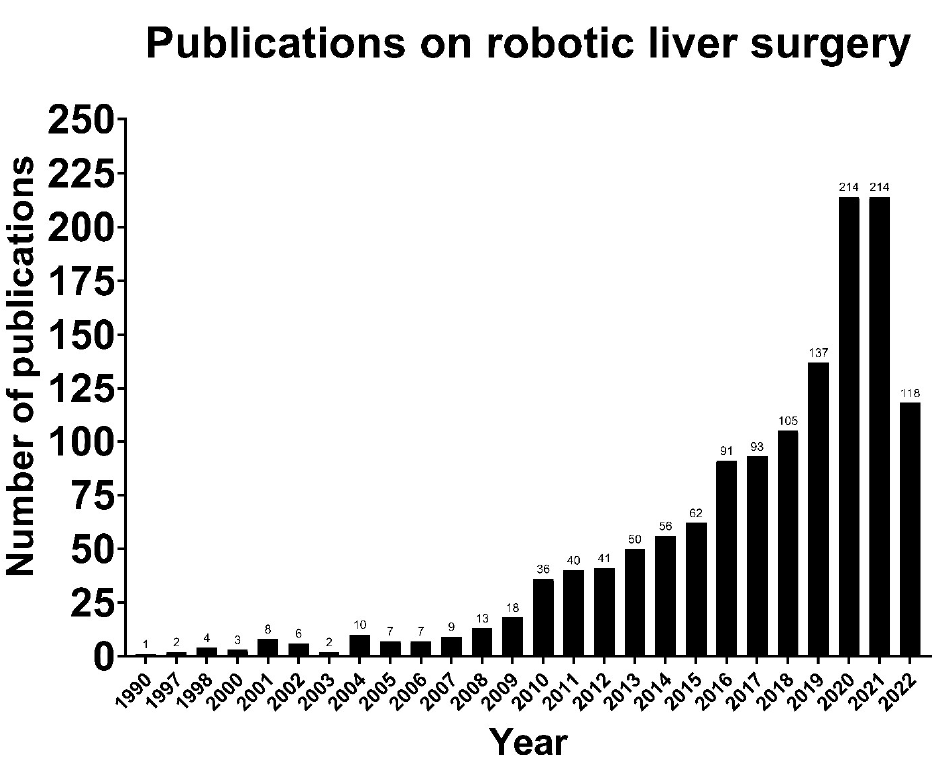
Figure 1. The number of publications on robotic liver surgery increasing over time (Source: Pub- Med).